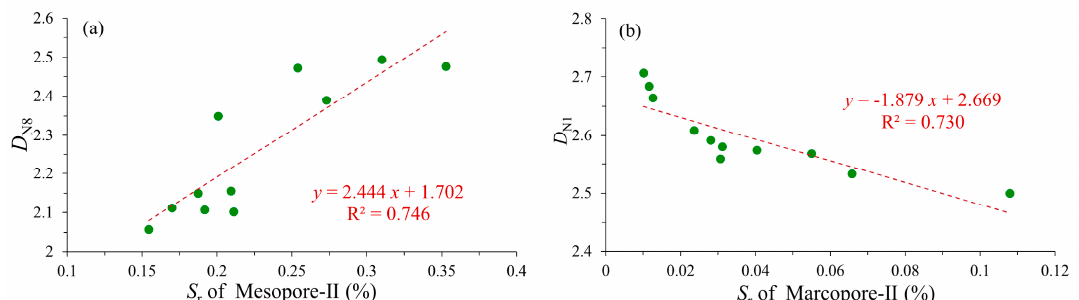
Figure 13. The relationship between S r and D N . ( a ) The relationship between S r of mesopore-II and D N8 ; ( b ) the relationship between S r of macropore-II and D N1 .